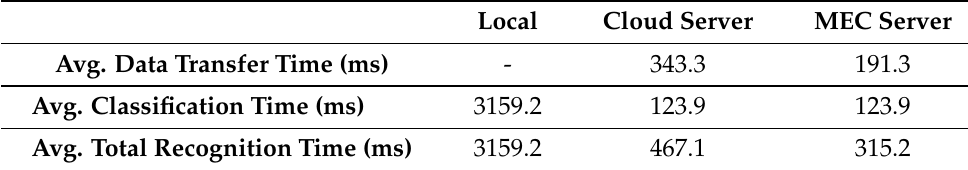
Table 7. Total waste recognition